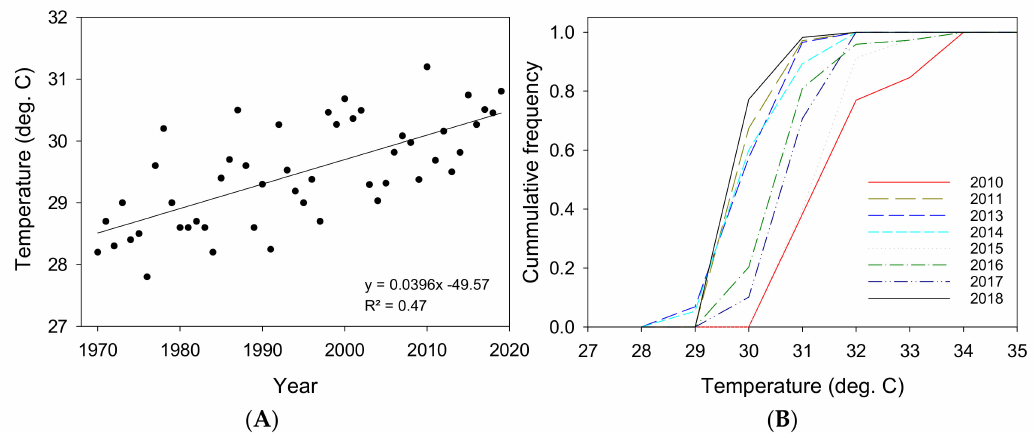
Figure 1. Long-term trends in water temperature ( A ) and a cumulative distribution of August water temperatures between 0–5 m ( B ) in Lake Kinneret. Water temperature data ( A ) cover the period 1970–2019 and represent the annual maximum water temperature at 1 m depth based on profiles conducted at a station located at the deepest point in the lake (Station A (Stn. A), Figure 2). The cumulative distribution ( B ) includes all available measurements collected between 2010–2018 by an automatic profiler, mounted with a Manta 35 + multiprobe, 4–6 times daily. Profiler data were not available for most of August, 2019, therefore 2019 is not included. The profiler is mounted on a fixed station located at Stn.